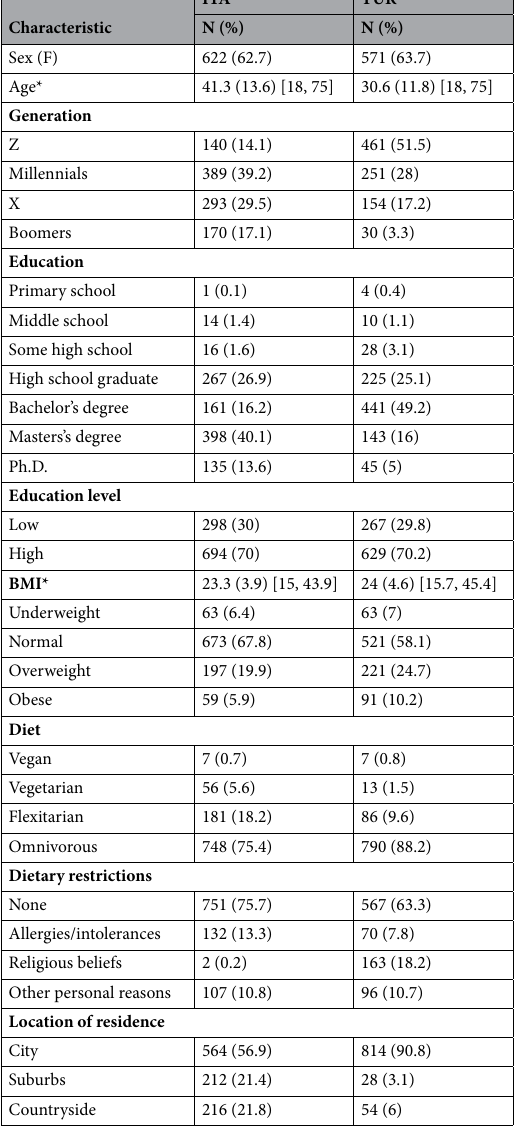
Table 1. Characteristics of the participants (N = 992 Italians, N = 896 Turkish). *Mean SD [min,